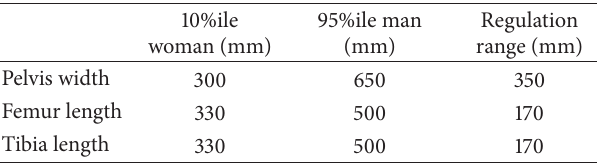
Table 1: P.I.G.R.O.